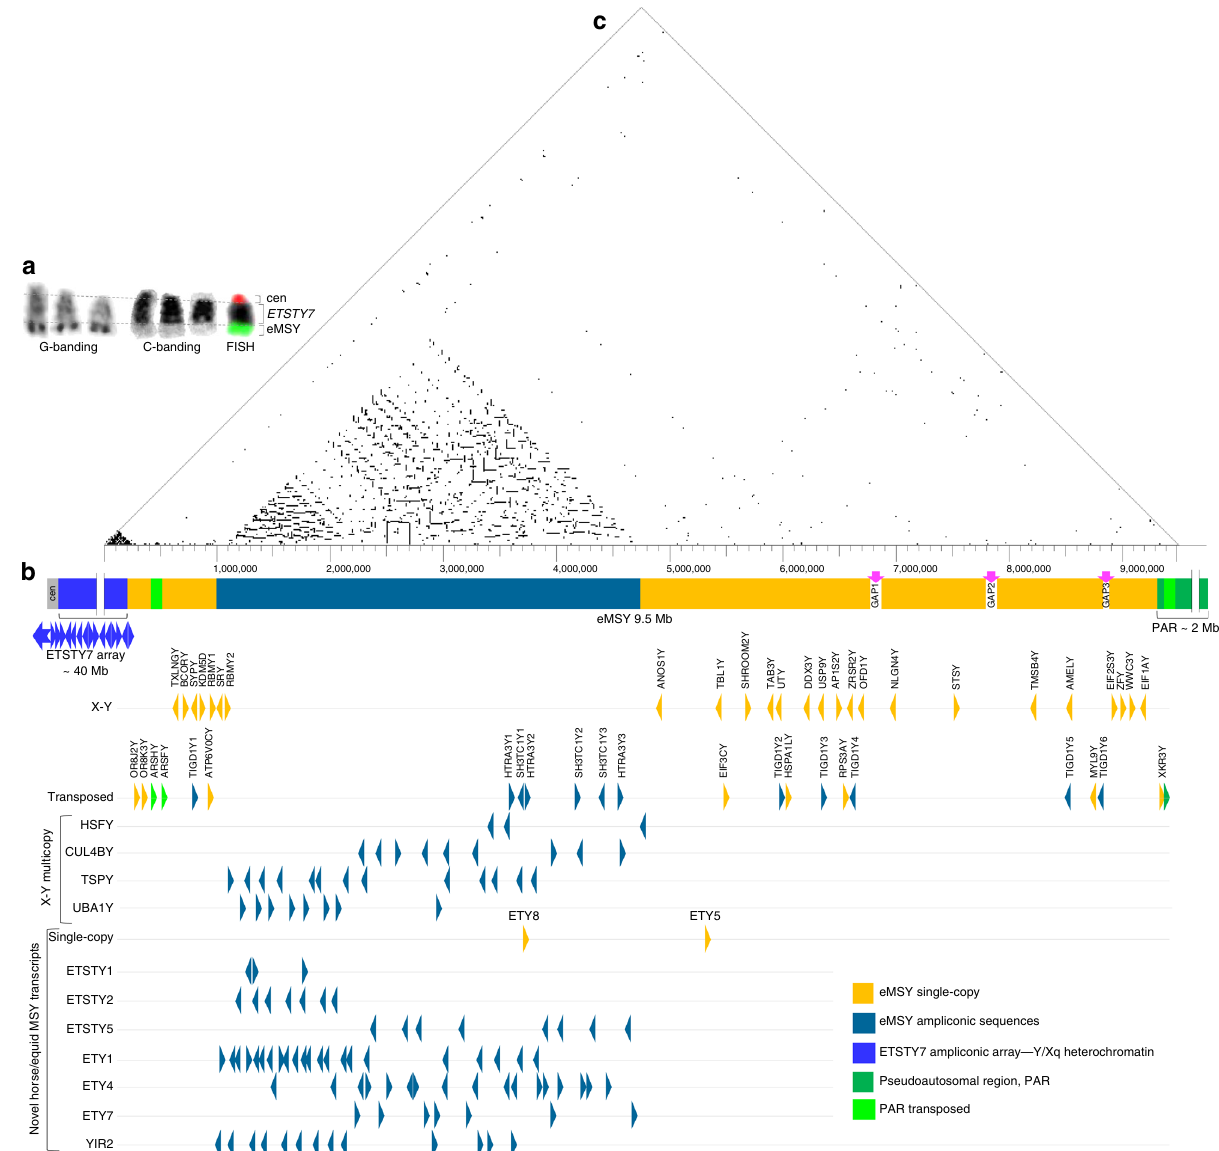
Fig. 1 Horse Y chromosome organization. a Cytogenetic features of the horse Y chromosome: G-band positive material corresponds to MSY (green FISH signal); C-band positive material corresponds to ETSTY7 ampliconic arrays; centromere is denoted by a red FISH signal (from published molecular pro fi le of horse Y 68 ); b Horse MSY sequence classes and gene map; c Triangular dot-plot showing the location of 100% identical sequences in MSY (with a 100 bp motif and a 20 bp